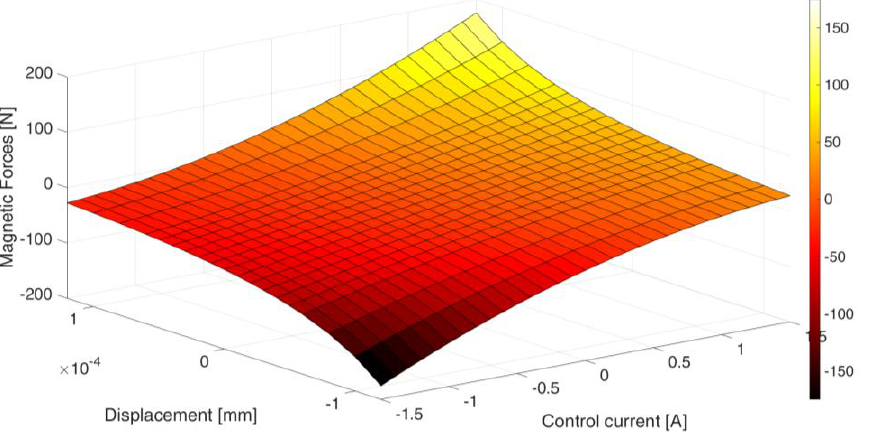
Figure 16. Magnetic force as a function of displacement of the rotor–shaft raceway in the air gap and control current.